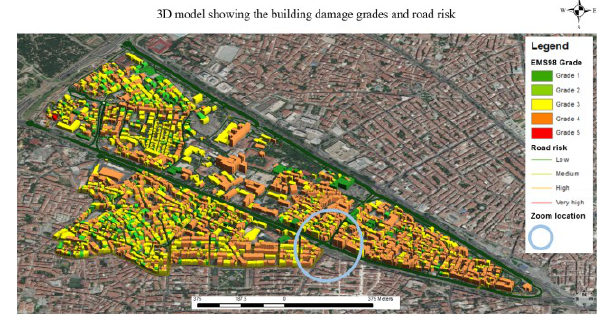
Figure 12 . 3D model of the entire area. Source: de Vries, 2022 This especially becomes apparent when zoomed-in as is done in Figure 13. It clarifies that the narrow roads with (very) high road closure risk are usually surrounded by heigh, very heavily damaged buildings, while the major road does not show this risk, where the road is not entirely blocked by debris due to its width.